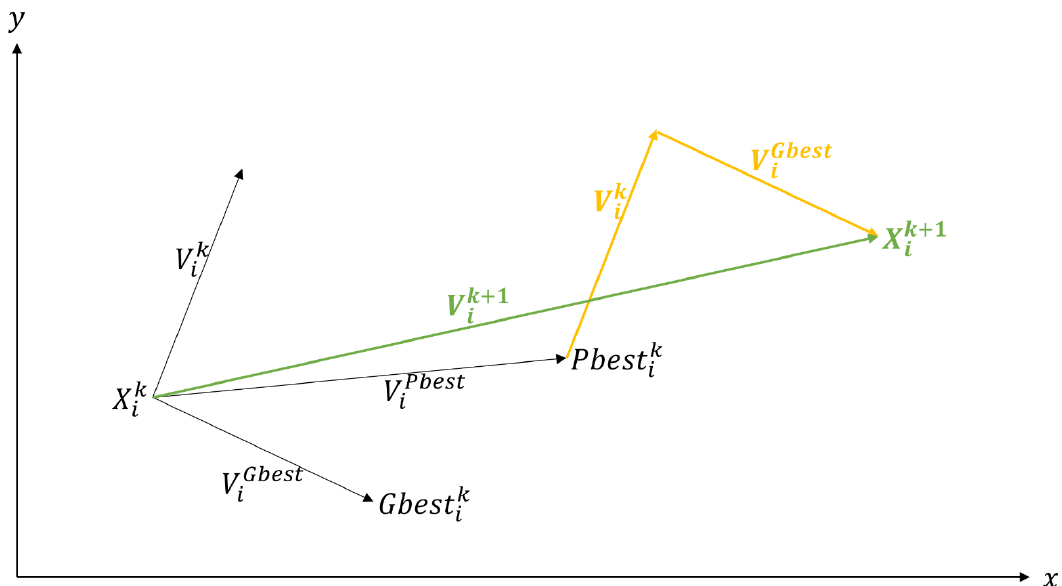
Figure 1. Search mechanism of the PSO algorithm modified from